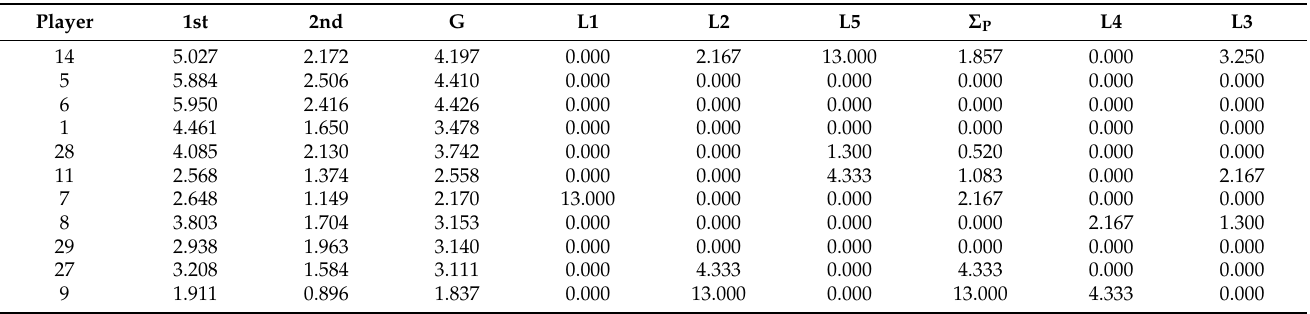
Table A4. Team B’s Closeness Centrality Matrix of